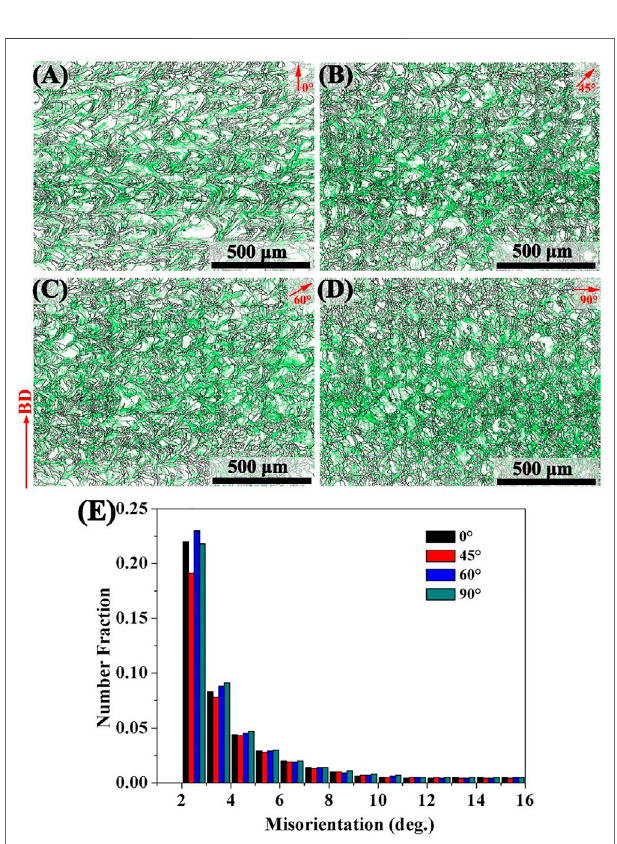
FIGURE 6 | Grain boundary misorientation angles of SLM-processed 316L SS from different angles relative to the build substrate: (A – D) angle of 0, 45, 60, and 90 and (E) the proportion of LAGBs in each